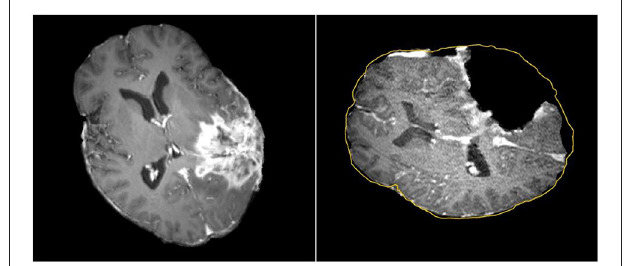
FIGURE 1 | Discrepancies between preoperative and intraoperative MR Imaging before and during neurosurgery. Left: preoperative MRI; Right: intraoperative MRI acquired after a part of the tumor is removed. The yellow outline indicates the preoperative brain outline after a rigid rotation. The large dark cavity is the tumor